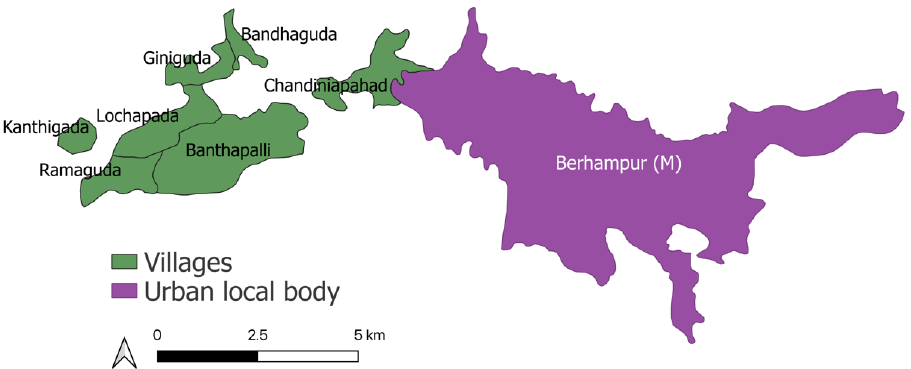
Figure 7. An example of a gram panchayat, Banthapalli (Ganjam district) with non-contiguous